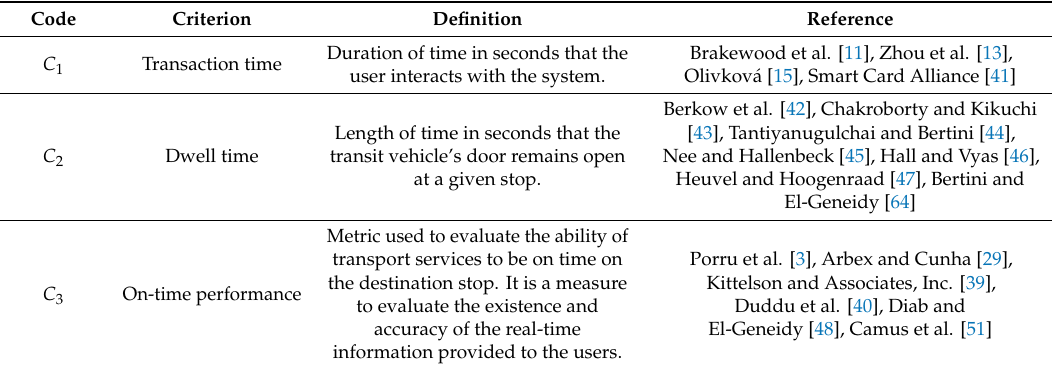
Table 1. Public transportation fare system evaluation